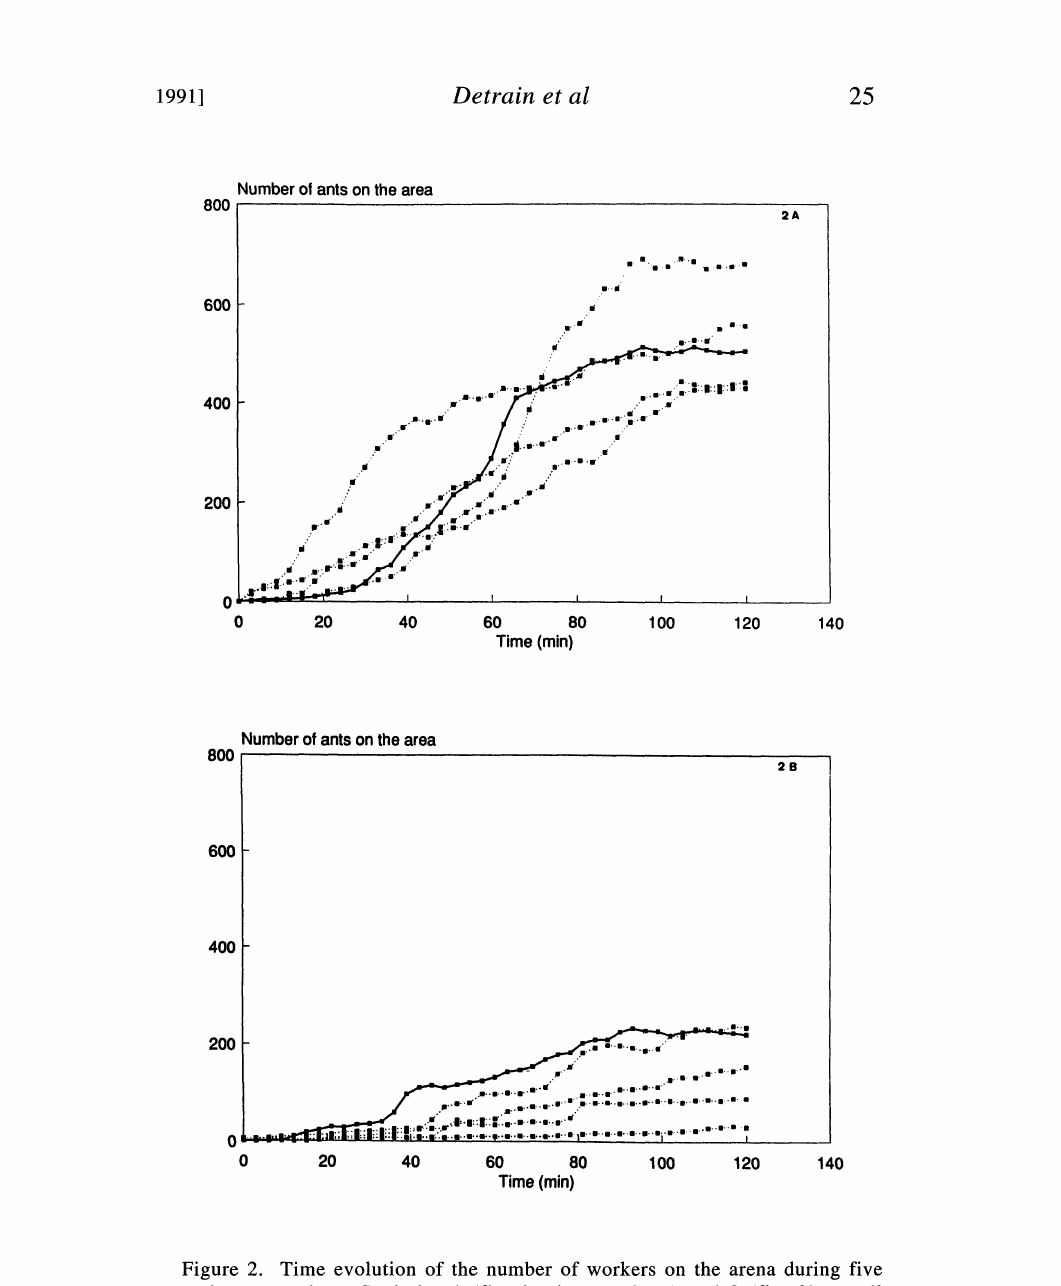
Figure 2. Time evolution of the number of workers on the arena during five experiments each on Societies (fig. 2a, large colony) and 2 (fig. 2b, small colony). The solid curve in fig. 2a corresponds to the experiment in fig.